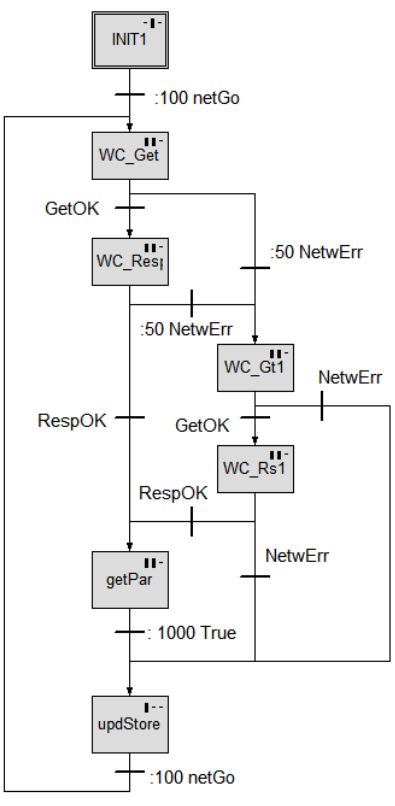
Figure 12. Example of use of the Network Communicator primitives.